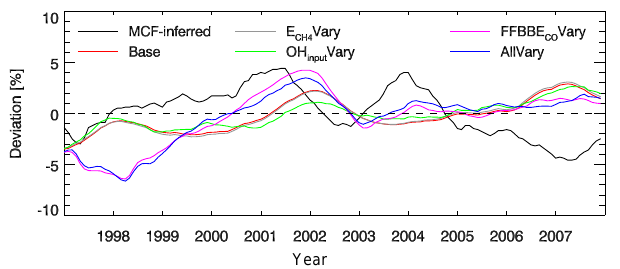
Figure 15. Deviations (%) of the global, mass-weighted, pseudo first-order rate constant ( k (cid:48) ) of the reaction of OH with MCF in- ferred from MCF measurements (black; adapted from Montzka et al., 2011) and from several scenarios.